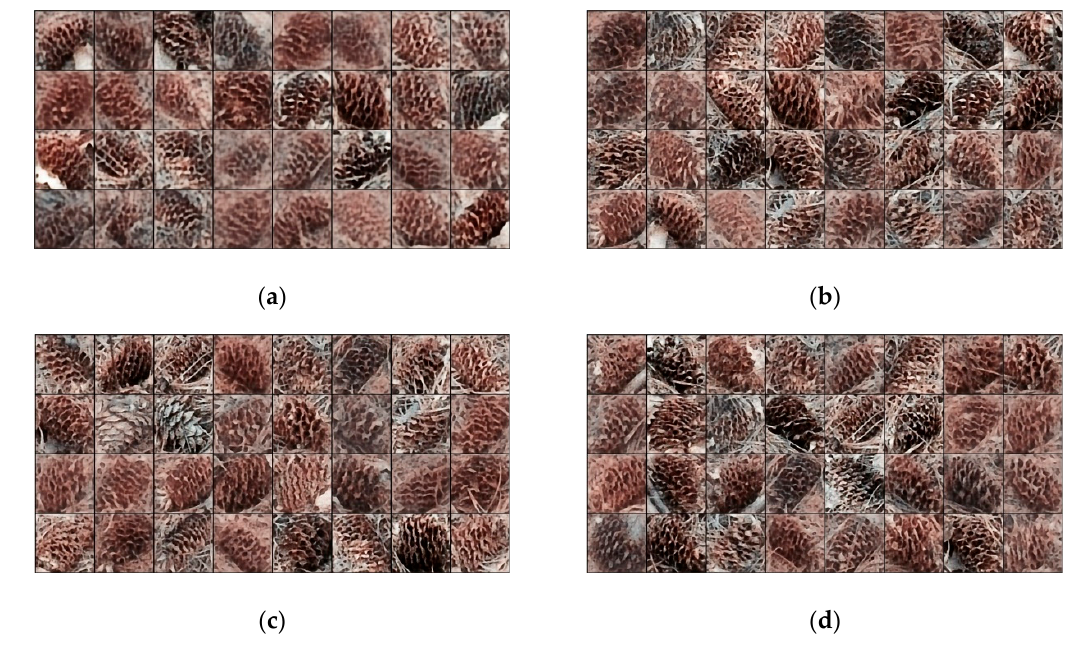
Figure 12. Generated pine cone images: ( a ) γ = 0.8; ( b ) γ = 0.6; ( c ) γ = 0.4; ( d ) γ = 0.2.